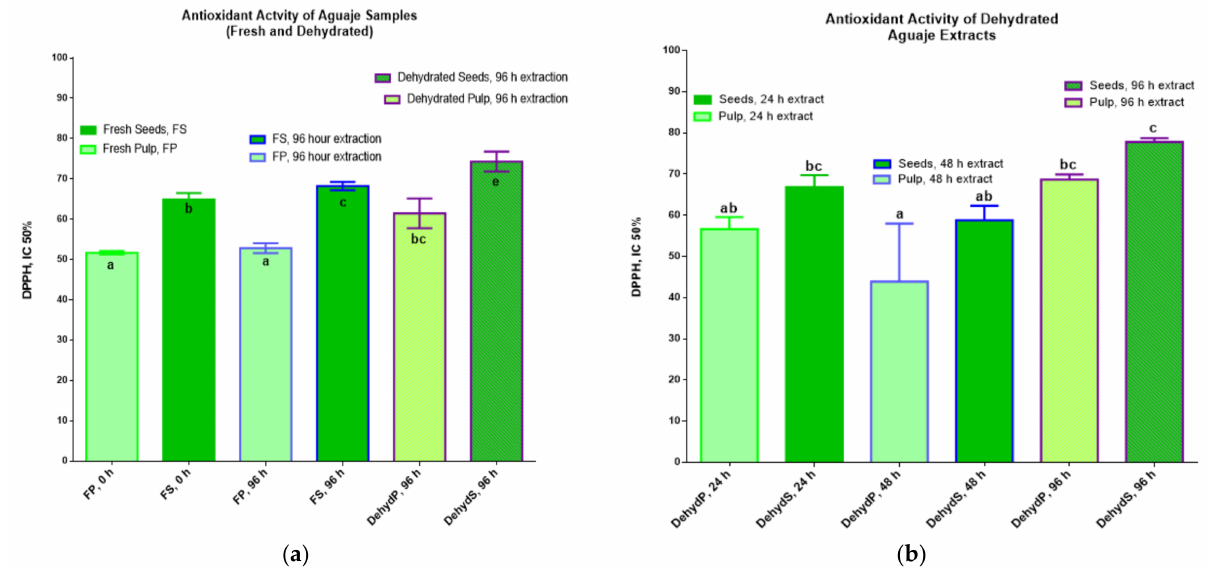
Figure 4. Antioxidant activity (mg AAE/100 g FP) of extracts in two different experimental assays. ( a ) fresh and dehydrated M. flexuosa ) and ( b ) dehydrated pulp and seeds at different times. Data are means ( ± standard deviation) and lower-case letters represent significant differences, for antioxidant activity of aguaje extracts according to DPPH (IC 50%), based on ANOVA followed by a Tukey test ( p <